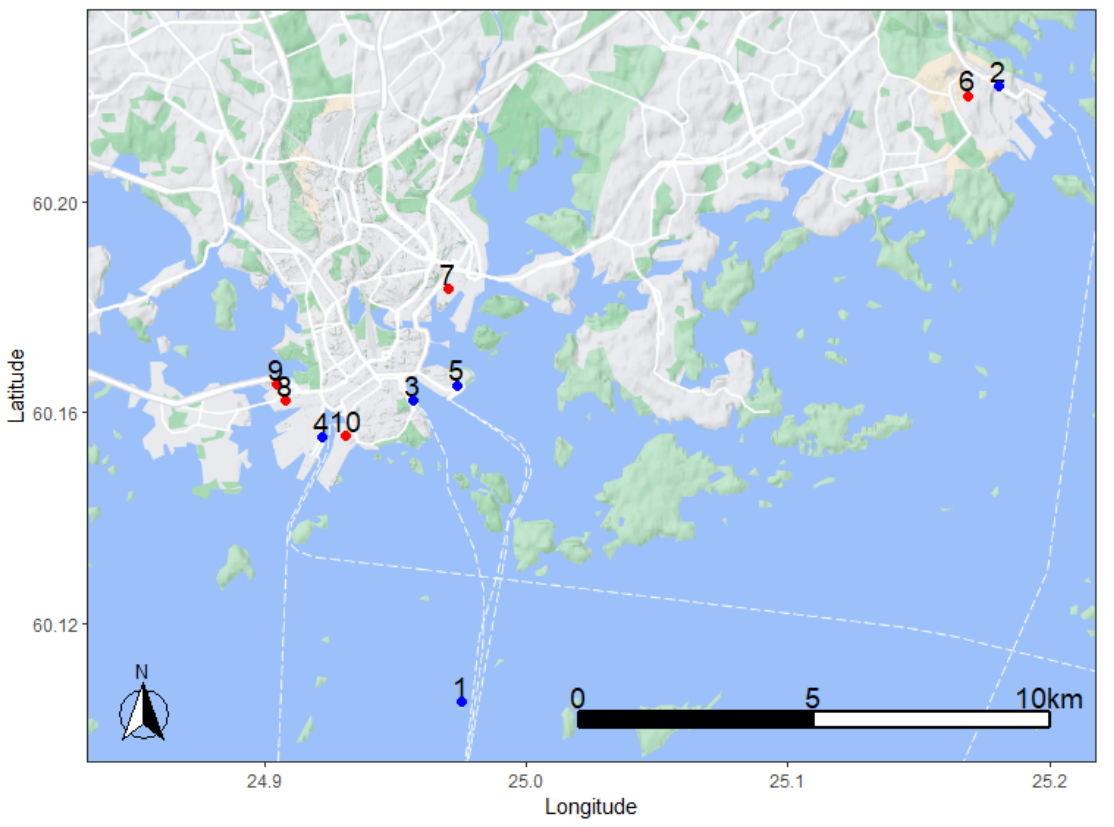
Figure 1. Map of city of Helsinki with the weather and port terminal air quality sampling locations (1: Harmaja lighthouse, 2: Vuosaari port terminal, 3: South harbour, 4: West harbour, 5: Katajanokka terminal) and electricity and district heating power plant locations, 6: Vuosaari natural gas plant, 7: Hanasaari coal power plant, 8: Kellosaari fuel oil backup plant, 9: Salmisaari coal power plant, 10: Munkkisaari fuel oil backup plant). Map data ©2023 Google.